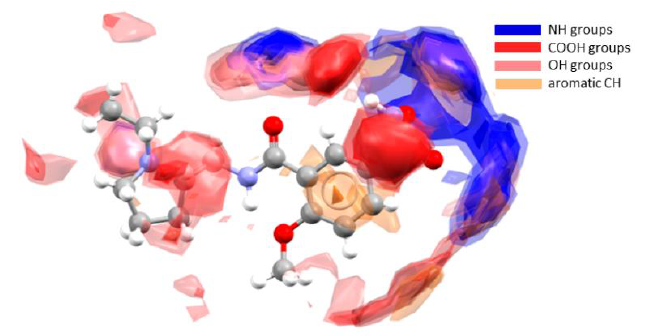
Figure 1. Full interaction map of SULP. Blue color indicates the probability of forming interactions with NH groups, red with COOH groups, pink with OH group, and orange π - π interactions.